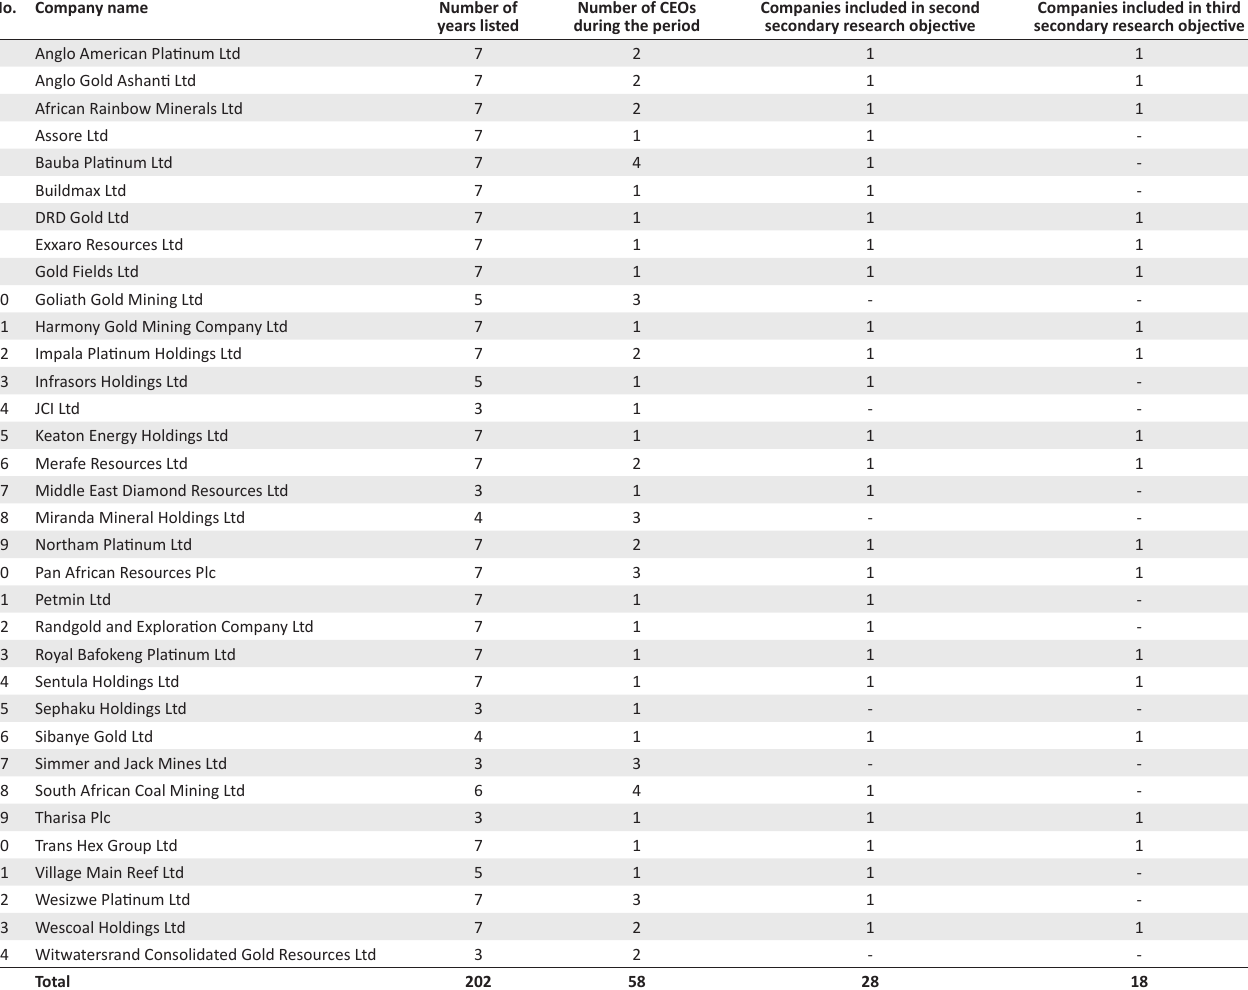
TABLE 1-A1: Final sample of mining